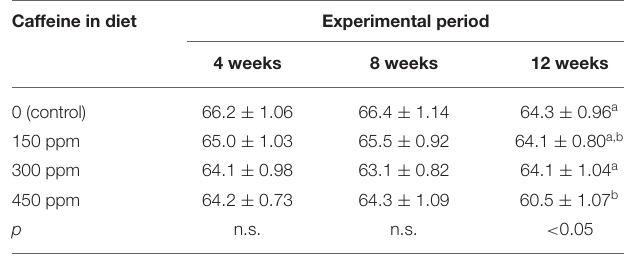
TABLE 4 | Weight of the eggs (in g) produced by laying hens fed rations containing different concentrations of caffeine for 12 weeks. Caffeine in